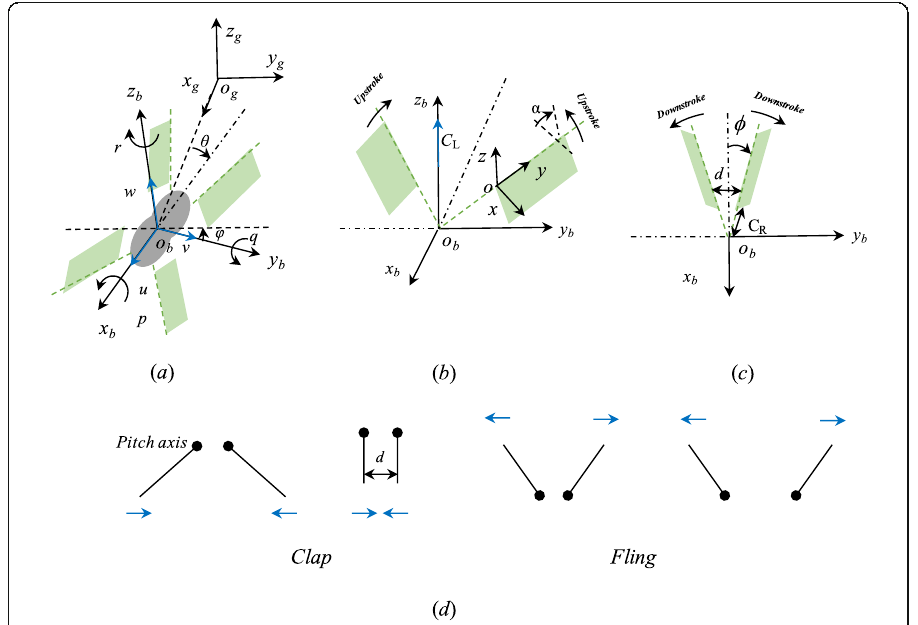
Fig. 3 The four-winged FMAV model sketch ( a - c ) Definition of coordinate systems and kinematics of four- winged FMAV, ( d ) as well as clap-and-fling motion schematic